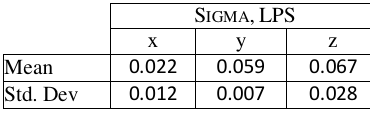
Table 12. Statistics of CPs residuals [m]